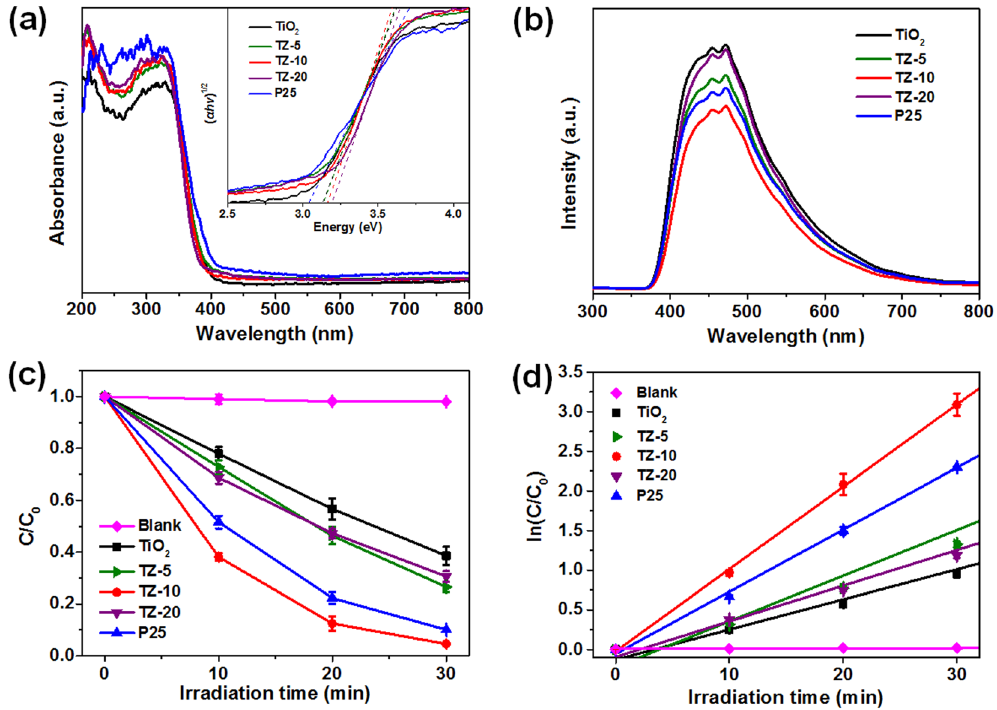
Figure 7. ( a ) UV-vis spectra and ( b ) PL spectra of TiO 2 , TZ-5, TZ-10, TZ-20, and P25. ( c ) Photocatalytic degradation performance and ( d ) kinetic linear fitting curves of MB over different samples under UV light irradiation. The inset showing the corresponding Kubelka-Munk transformed reflectance spectra to determine the indirect new bandgap values of the as-synthesized